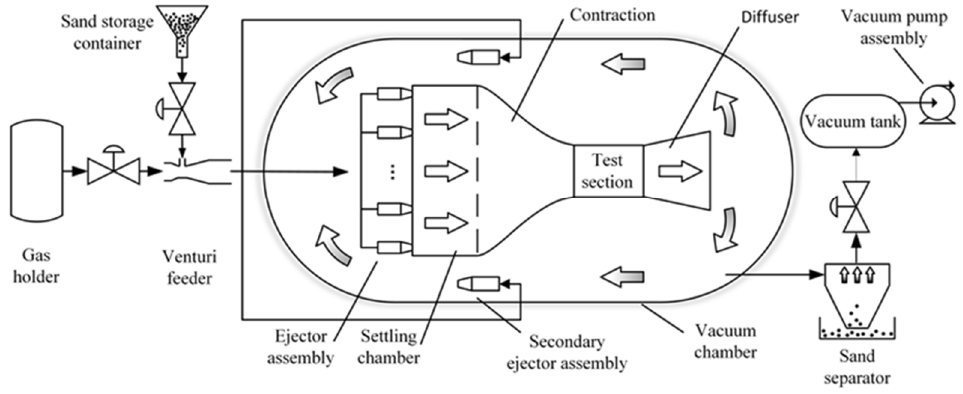
Figure 1. General layout of the Mars wind tunnel.